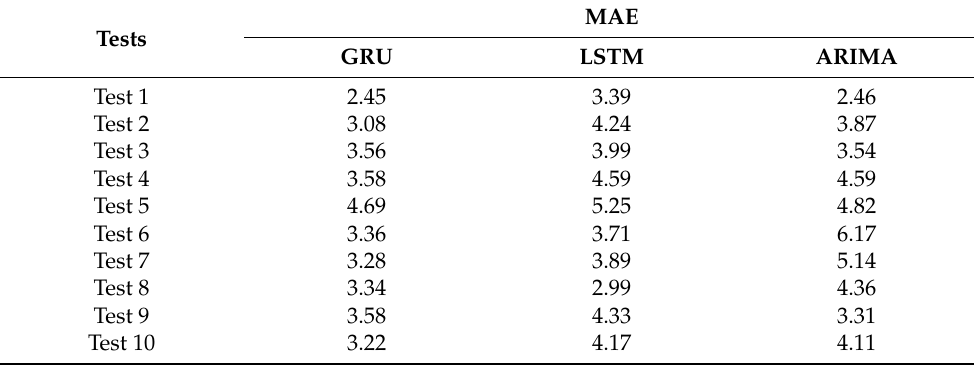
Table 2. Prediction performance comparisons in bus lanes.